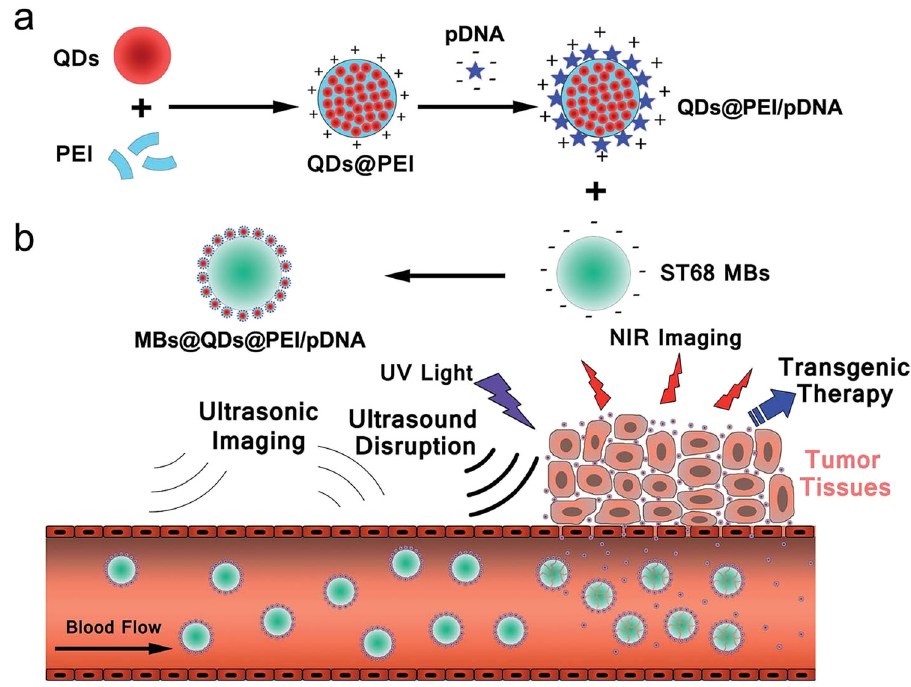
Figure 3: Schematic diagram of: ( a ) MBs@QDs@PEI/pDNA formation, ( b ) NIR fl uorescence and target delivery by ultrasound - targeted microbubble destruction; with permission from ref. [ 67 ] ; Royal Society of